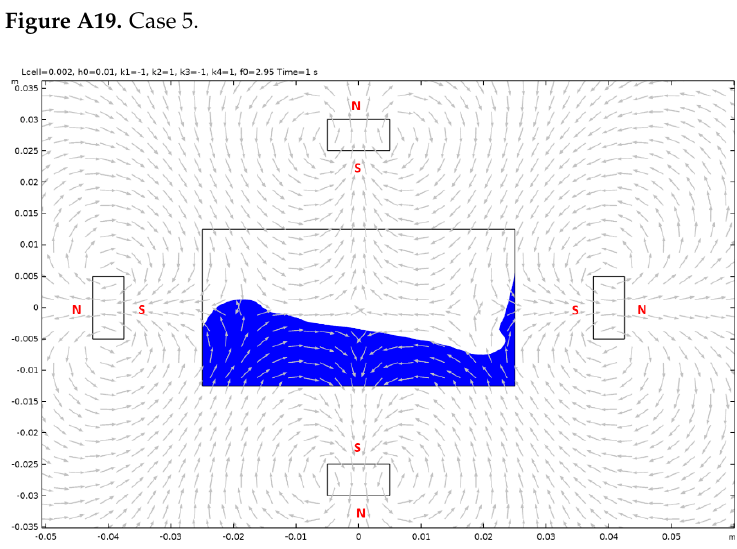
Figure A19. Case 5.